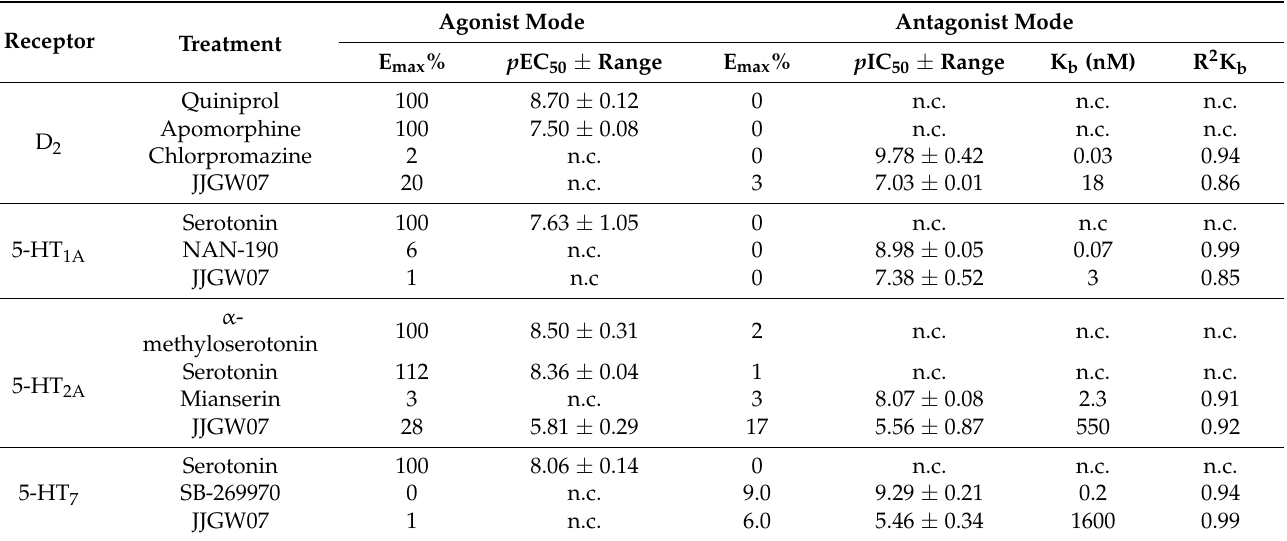
Table 1. The intrinsic activity of JJGW07 for dopamine D 2 and serotonin 5-HT 1A , 5-HT 2A , and 5-HT 7 receptors.